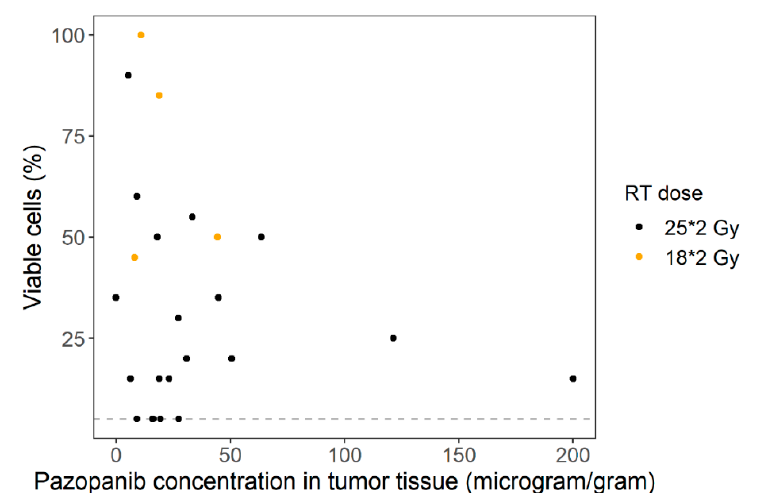
Figure 3. Pazopanib concentrations in tumor tissue versus percentage of viable tumor cells in resection specimen ( ρ = − 0.10, p = 0.63). The dashed line represents the cut-off value for a good response, which is ≤ 5% viable tumor cells. Patients which are shown as black dots were treated with a radiotherapy dose of 50 Gy, and patients which are shown as orange dots were treated with a radiotherapy dose of 36 Gy.